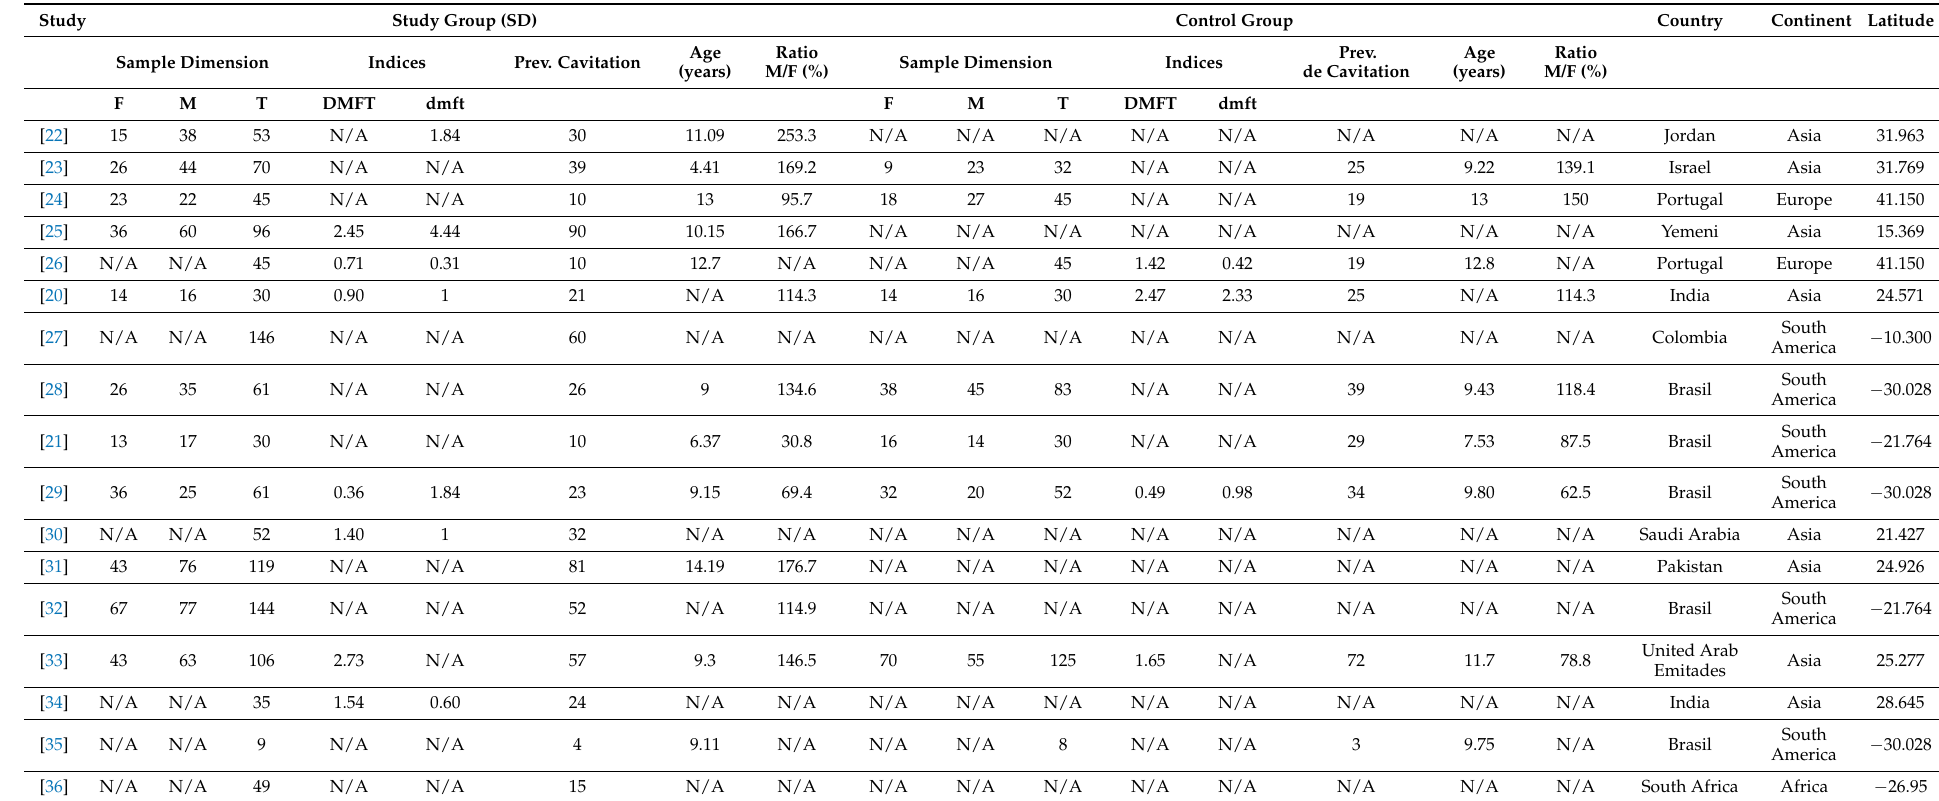
Table 1. Studies included in the systematic review and